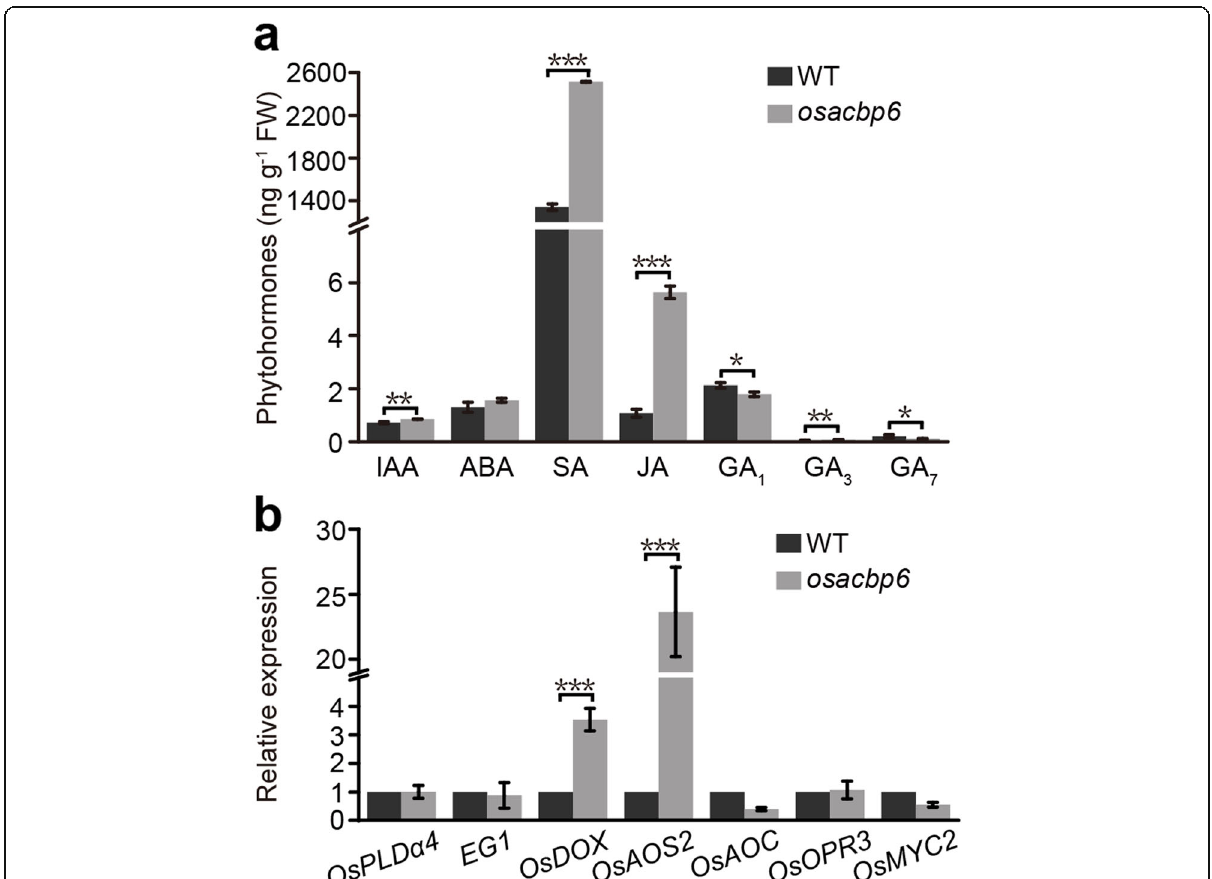
Fig. 7 Alteration of plant hormone levels in the rice osacbp6 mutant. a Measurement of plant hormone content in 21-day-old leaves. b Relative expression of genes related to JA biosynthesis and its signaling pathway. Values are means ± SD ( n = 3). Asterisks indicate significant differences between the wild type (WT) and osacbp6 as evaluated by Student ’ s t -tests: * P < 0.05, ** P < 0.01, *** P < 0.001. WT, Oryza sativa var. japonica cv. Dongjin. IAA, indole-3-acetic acid; ABA, abscisic acid; SA, salicylic acid; JA, jasmonic acid; GA, gibberellin; PLD, phospholipase D; EG1, EXTRA GLUME 1; DOX, α -dioxygenases; AOS, allene oxide synthase; AOC, allene oxide cyclase; OPR, OPDA